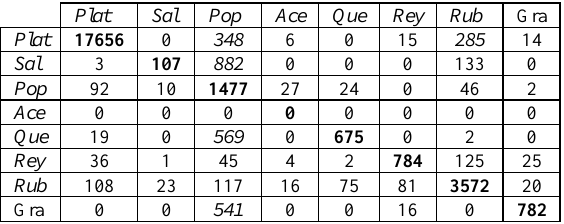
Table 6 . Confusion matrix obtained with RLR- ℓ1 for assessment on the impacted area. See species in Table 1.